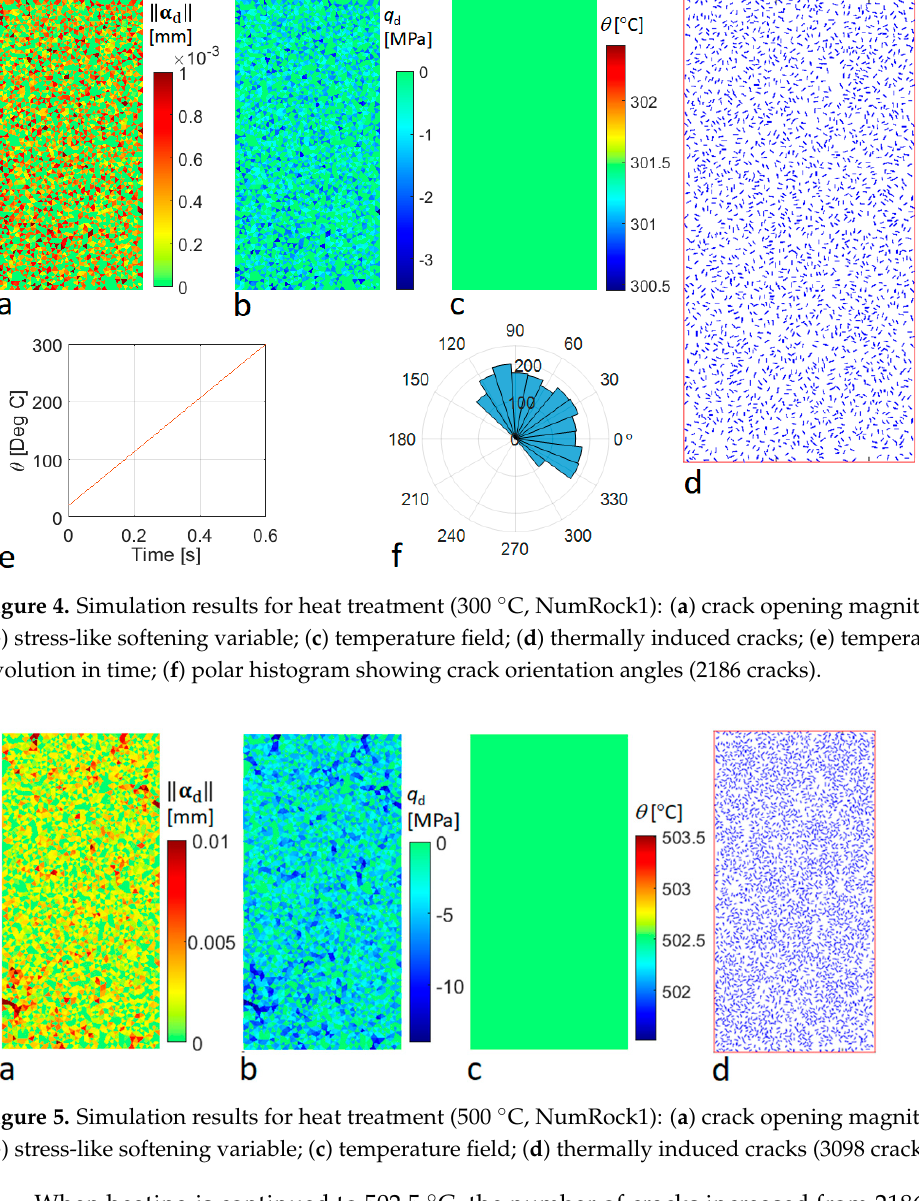
7 of 14 Figure 3. Tensile strength distribution in numerical rock samples (quartz = white, feldspar = gray, biotite = black). As mentioned in the Introduction, the temperature dependence of the material pa- rameters is reduced to that of the thermal expansion. The tensile strength of granite at elevated temperatures is measured for a specimen and is first heated slowly to the target temperature and then cooled down to room temperature. This heat treatment induces cracks in the sample, leading to degradation of its tensile strength. For heterogeneous brit- tle materials with inherent flaws (e.g., microcracks), the tensile strength is an emerging property, representing the sample integrity under extensional loading, not a material property per se at the material point level. Therefore, it would beg the question to feed the experimental tensile strength at certain temperature into the material point level constitu- tive law and then predict that same strength. Thereby, the mechanical and thermal properties, except for the thermal expansion coefficient, are assumed temperature independent during heat treatment simulations. The thermal expansion coefficient of quartz depends on temperature, as follows: 𝛼 (cid:2927) (𝜃) = 𝛼 (cid:2927)(cid:2868) (cid:3436)1 + 0.75 823 − 293(cid:3440) (𝜃 − 293), [1/K] (15) where 𝛼 (cid:2927)(cid:2868) is the thermal coefficient at room temperature. According to (15), the thermal expansion of quartz depends linearly on a temperature in the range of 20–550 ° C. This is of course not fully realistic (see [7]) but a consequence of the present simplified modeling approach of using homogenous material properties (except the tensile strength) and re- ducing all the temperature dependent heterogeneity to that of quartz, as mentioned above. However, it will be shown that this approach predicts the thermal weakening effect with a reasonable accuracy. 3.2. Simulations of Rock Heat Treatment The numerical rock samples are heated uniformly to target temperatures of 300 ° C and 500 ° C. As the slow heating of rock does not induce inertia forces, extreme mass scal- ing can be used for the mechanical problem. Specifically, a million-fold density is used to increase the critical time step of the explicit time marching 1000-fold. In order to secure a